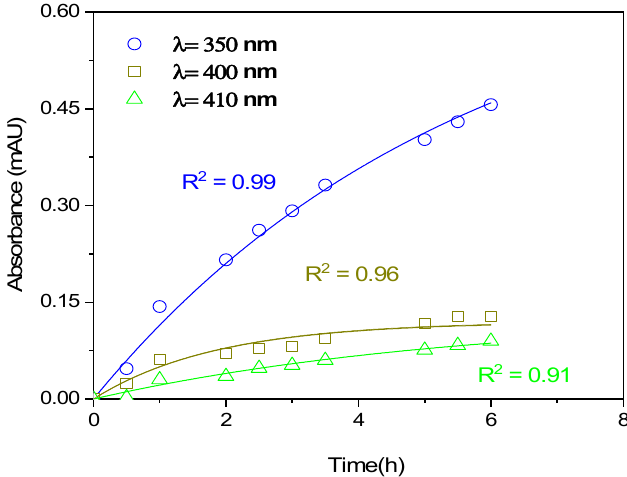
Figure 7. BrC formation in the reaction mixture of 0.1 mM 3-methylcatechol and 2 mM NaNO 2 in the dark. Experimentally measured (symbols) and modelled absorbance (solid lines) at different wavelengths, representative of BrC are shown.